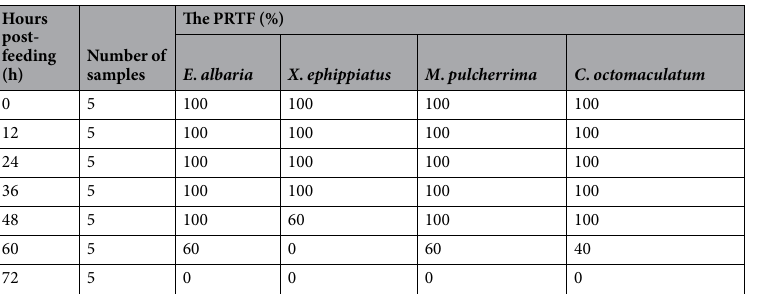
Table 3. Detection efficiency in adult spider individuals at various time after feeding on one adult E . vitis using TaqMan